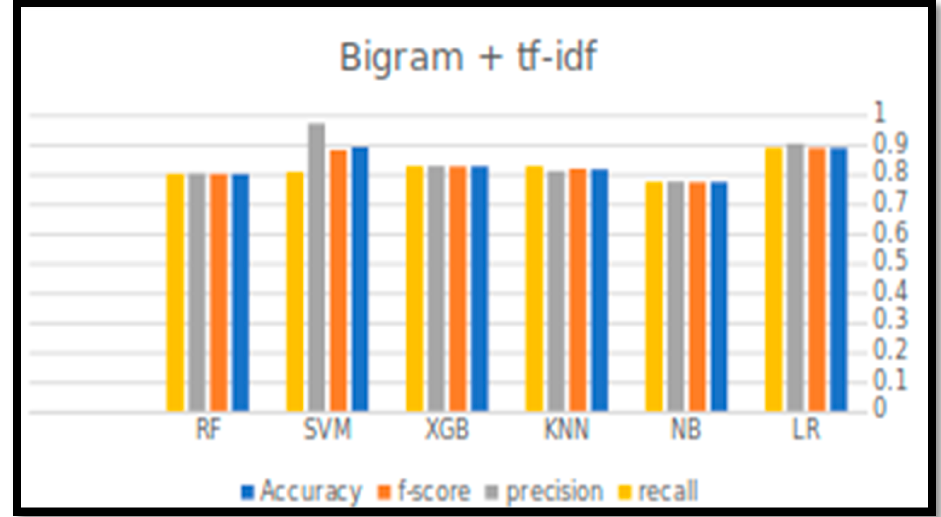
Figure 4. Performance measure results for all classification algorithms with bigram TF-IDF.